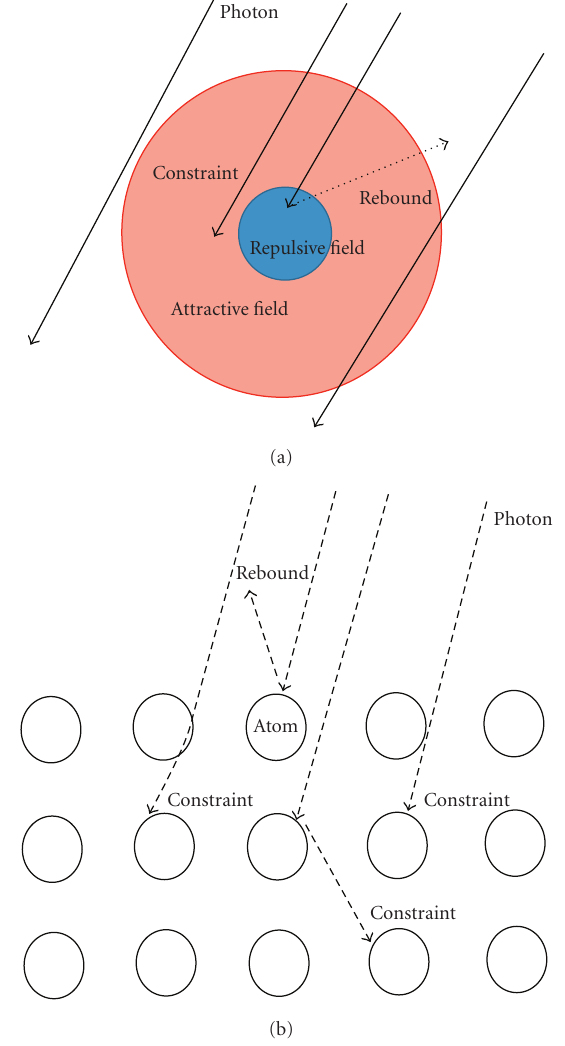
Figure 1: Illustrations of attractive and repulsive interaction of atoms and photons. (a) The photons move toward repulsive force field is probably rebound out, and the other photons move through attractive field is constrained or decelerated. (b) The rebounded behavior is as same as reflection. The constraint behavior is as same as